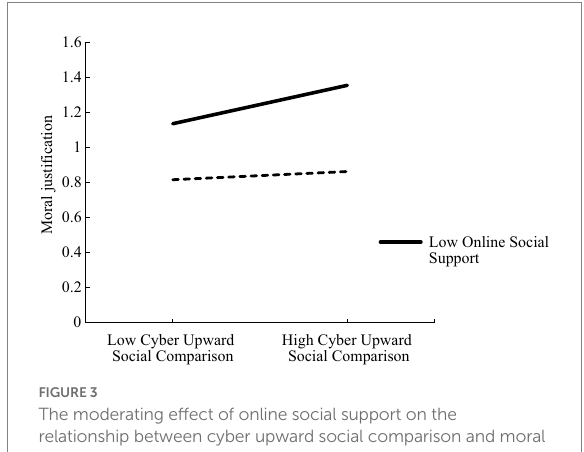
FIGURE 3 The moderating effect of online social support on the relationship between cyber upward social comparison and moral